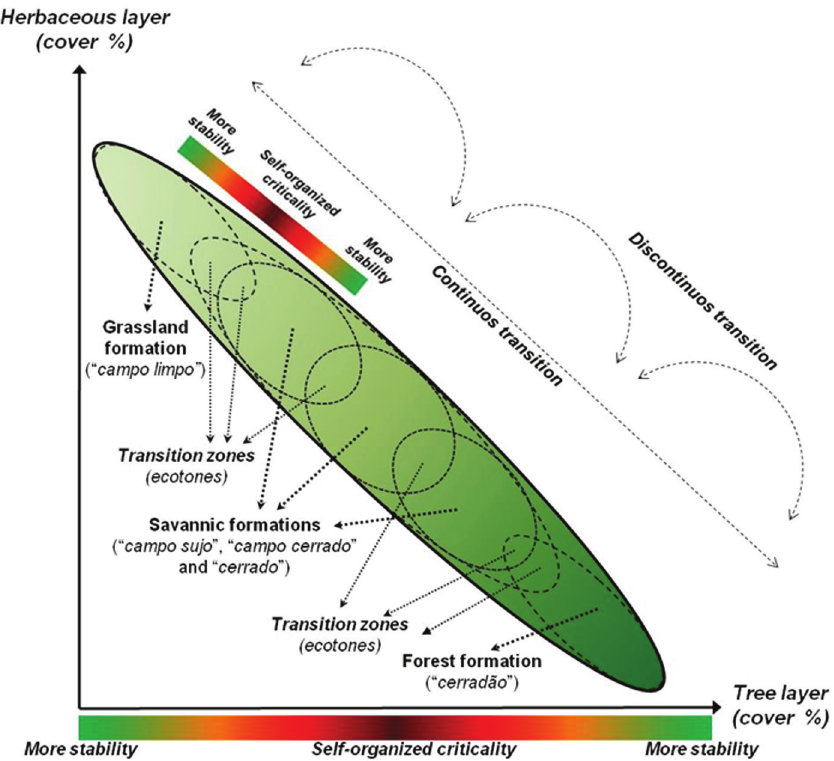
Figure 2 - Schematic representation of organization and dynamics of